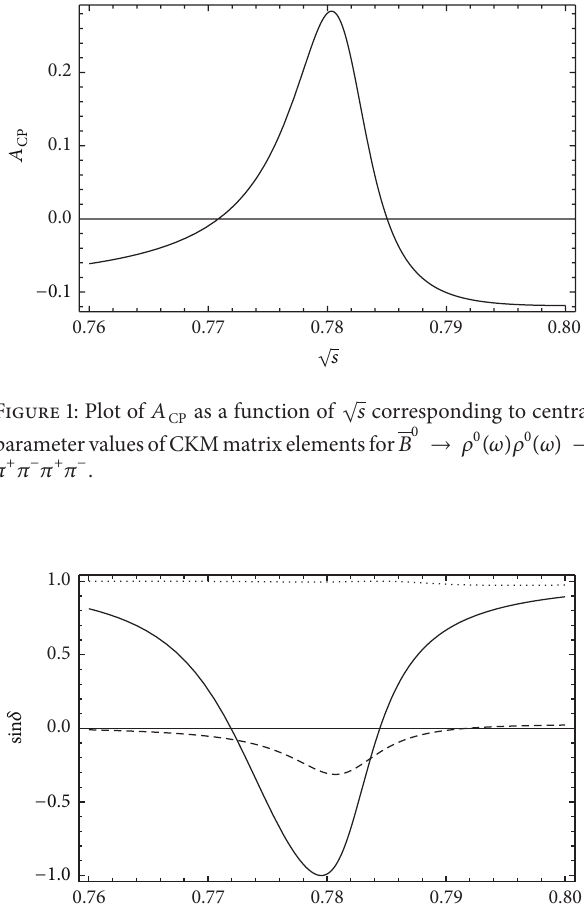
0 → 𝜌 0 (𝜔)𝜌 0 (𝜔) → 0